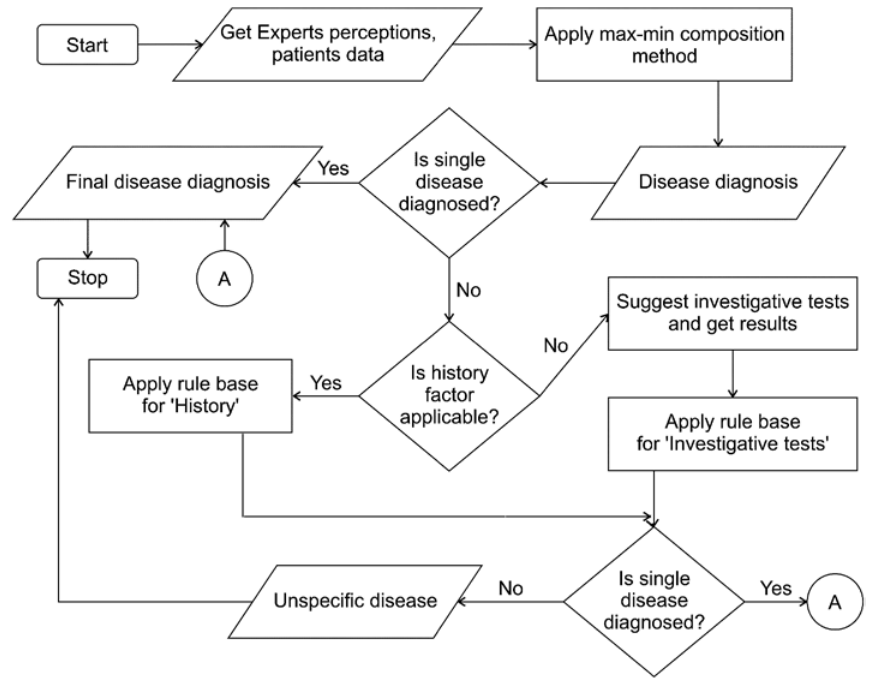
Figure 1: Fuzzy Logic-Based Formalism for the Diagnosis of Gynecological